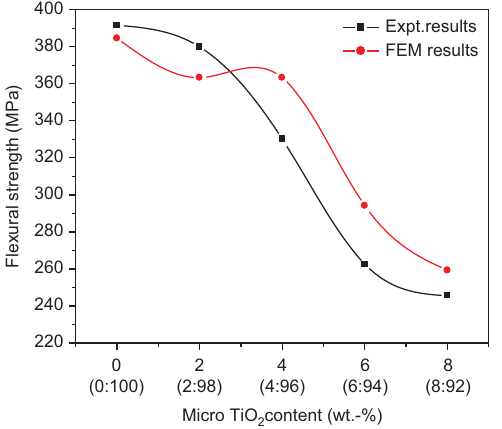
Figure 6 Effect of micro-TiO A384 alloy